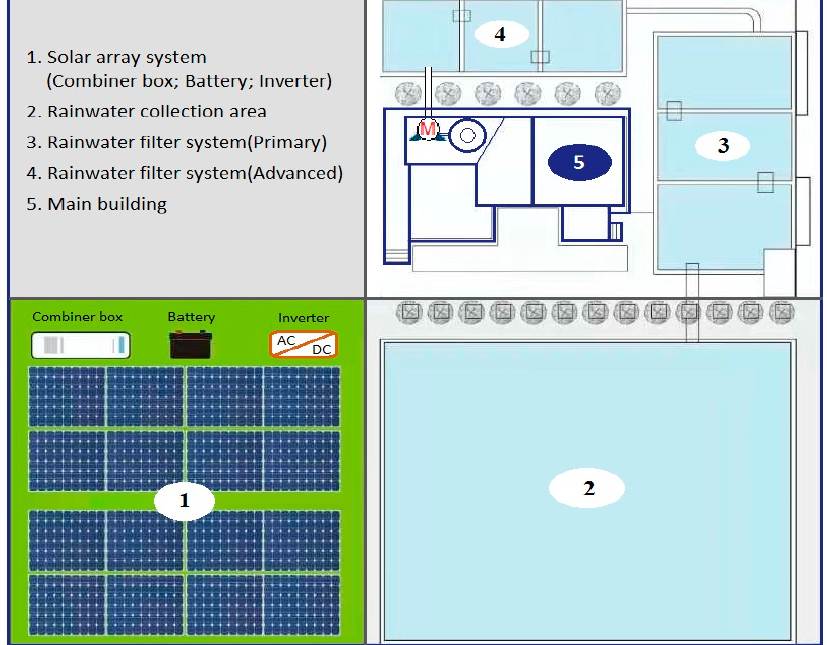
Figure 7. Green and ecological facilities of the residential house.